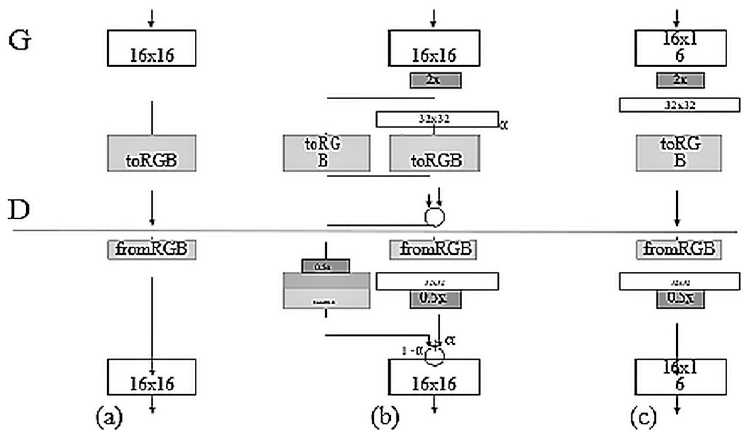
Figure 25. The fading of layers during the training process. The layers go from ( a ) to ( b ) by assuming the already-trained layers as a residual block where the weights move from 0 to 1.